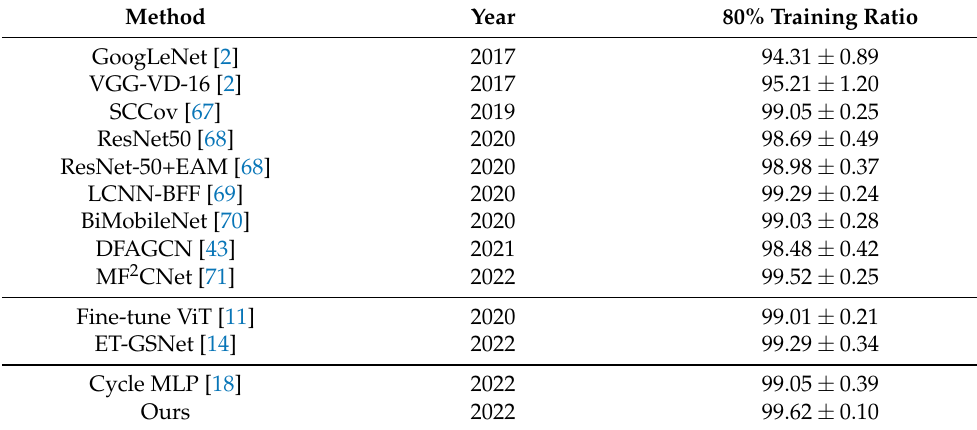
Table 2. The comparison of OA on the UCM